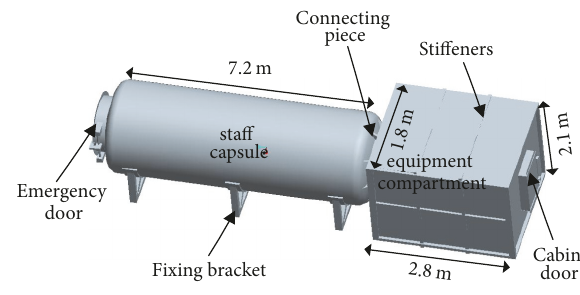
Figure 1: Geometry of rescue